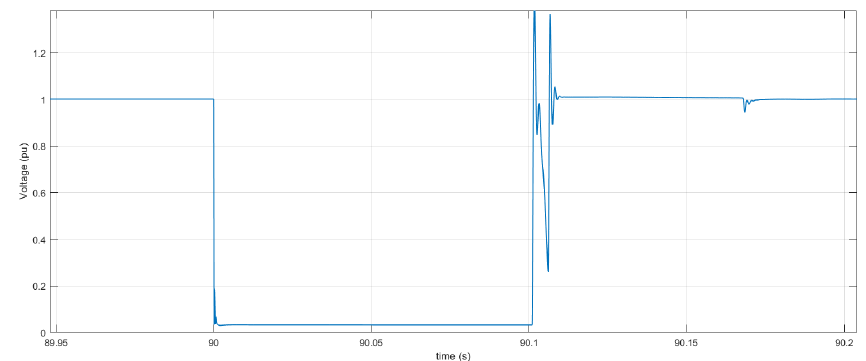
Figure 21. rms value of voltage at bus 1 in response to the three phase